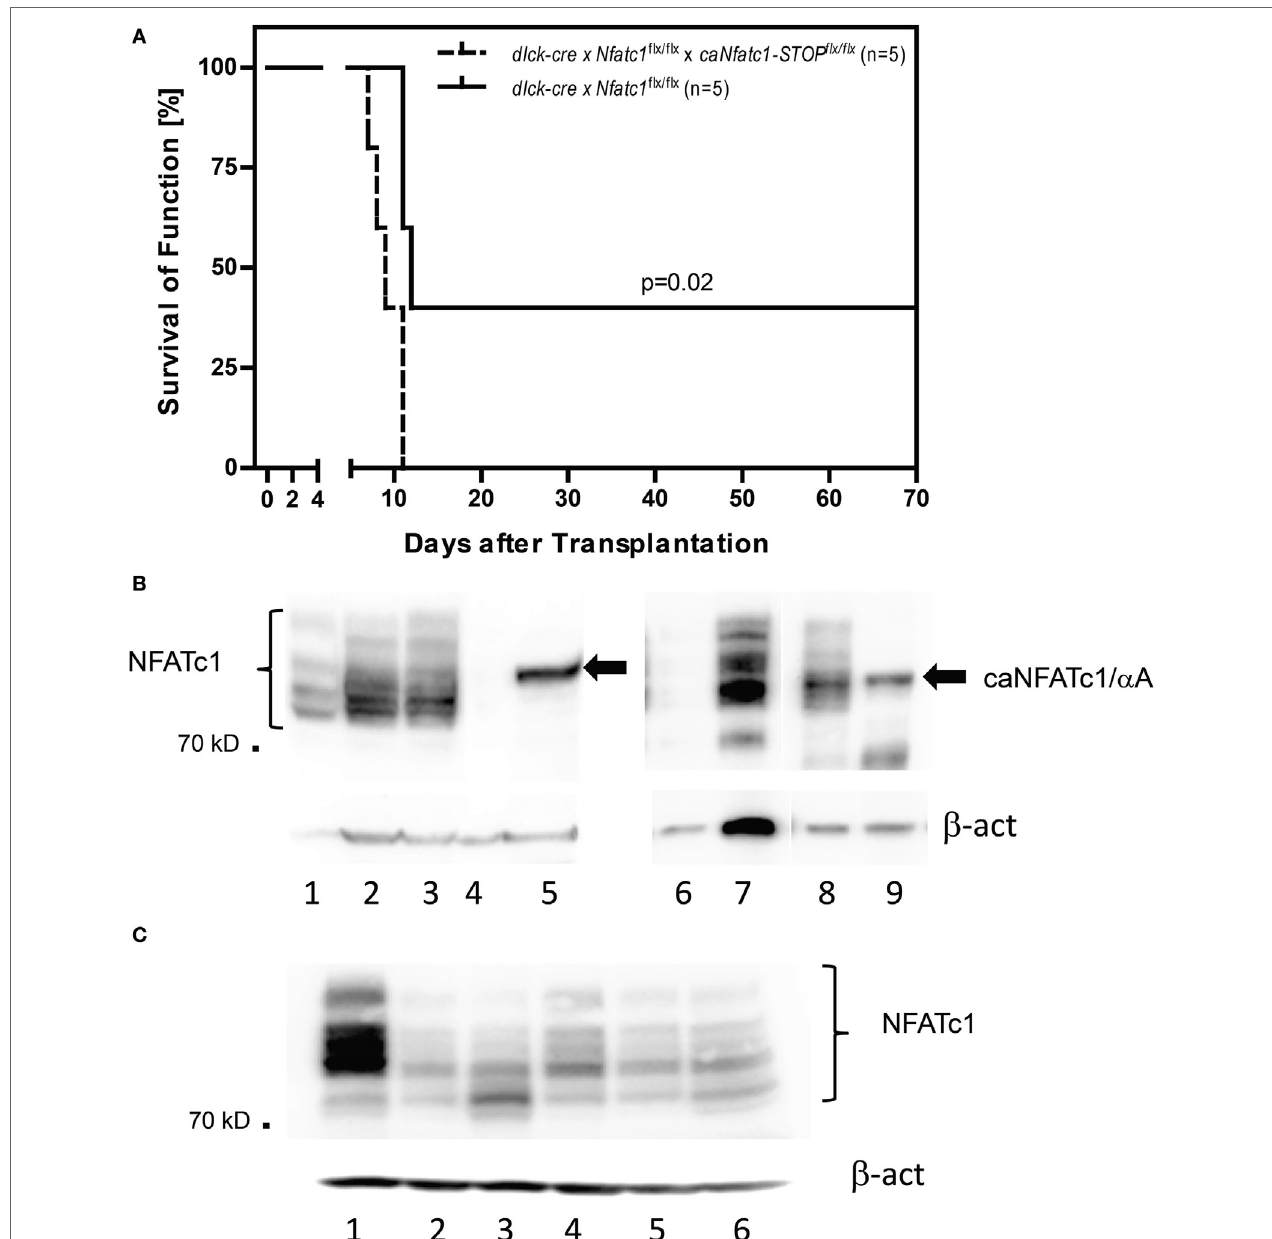
FigUre 2 | Expression of NFATc1/ α A in peripheral T cells leads to rejection of allogeneic heterotopic heart transplants. (a) Allogenic heart grafts (of BALB/c mice) were transplanted into five dlck-cre x Nfatc1 flx/flx mice, or five dlck-cre x Nfatc1 flx/flx x caNfatc1-STOP flx/flx mice expressing a constitutive active (ca) version of NFATc1/ α A in peripheral T cells. (B) Immunoblots showing the expression of caNFATc1/ α A in CD8 + T cells from two out of five dlck-cre x Nfatc1 flx/flx x caNfatc1- STOP flx/flx mice. In lanes 1 and 6, cytosolic protein, in lanes 2, 3, and 7 nuclear protein from wild-type (WT) CD8 + T cells stimulated by α CD3/CD28 antibodies (Abs) in vitro for 2 days was fractionated. In lanes 4 and 8, cytosolic protein, and in lanes 5 and 9 nuclear protein of CD8 + T cells activated for 2 days from dlck-cre x Nfatc1 flx/flx x caNfatc1-STOP flx/flx mice was fractionated. (c) Immunoblot showing NFATc1 expression in CD8 + T cells from five dlck-cre x Nfatc1 flxl/flx mice. In lane 1, whole cell protein of WT CD8 + T cells stimulated by α CD3/CD28 Abs in vitro for 2 days was fractionated, in lanes 2–6, whole cell protein of activated CD8 + T cells from dlck-cre x Nfatc1 flx/flx